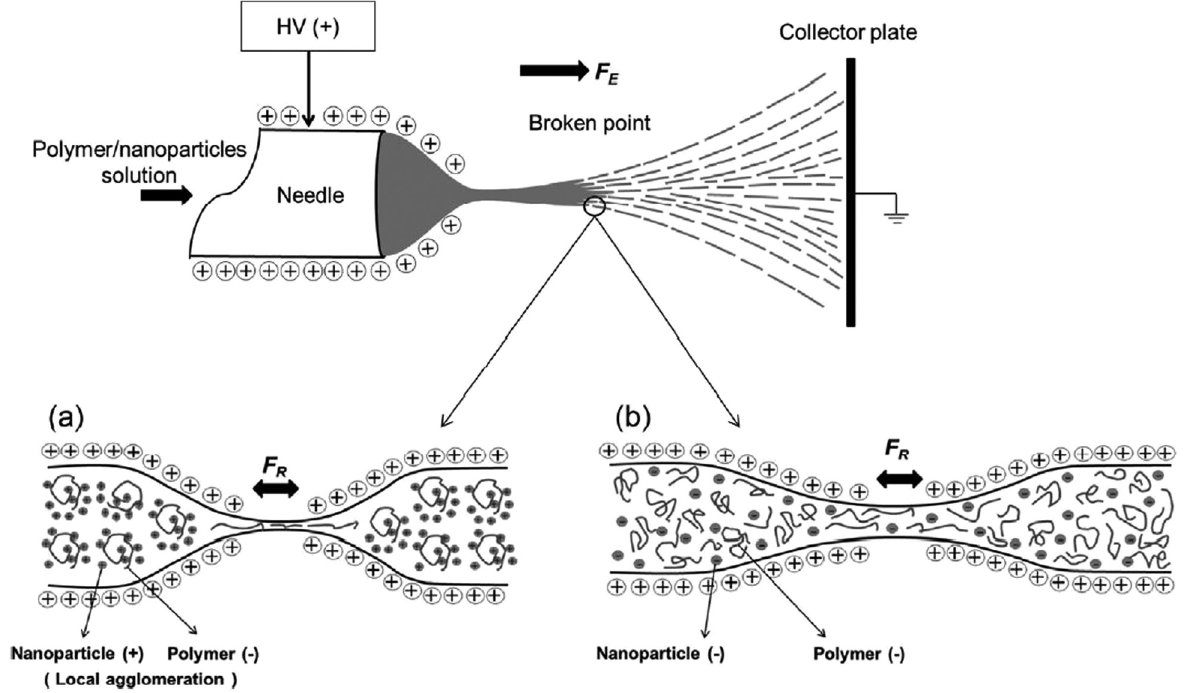
Figure 5: Breakage mechanism and repulsive force generation in polymer jet at ( a ) pH = 4 and ( b ) pH = 9 [ 107 ] ; Copyright 2014, reproduced with permission from Elsevier Ltd.